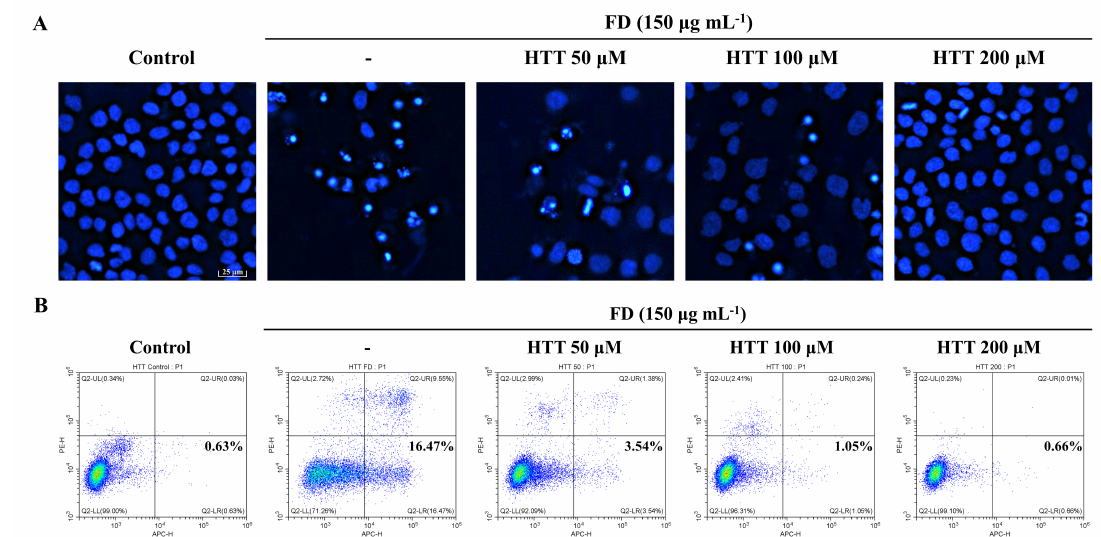
Figure 2. The e ff ect of (–)-loliolide (HTT) on apoptotic body formation and early apoptosis in fine dust (FD)-induced HaCaT cells. Fluorescence microscopy of nuclear morphological analysis using ( A ) Hoechst 33342 dye and early apoptosis detection by ( B ) annexin V with flow cytometry. HTT pre-treated (50–200 µ M) exposed to FD for one hour before replenishing with new media. The experiments were conducted in triplicates with three independent trials to confirm repeatability.